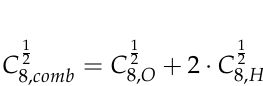
Figure 5. Position r M of the off-atom (M) site along the x -axis in Figure 1 versus the root-mean-square Figure 5: Position r of the off-atom (M) site along the x-axis in Figure 1 versus the root- M deviation (RMSD) between the partial-charge fitted and QM (B3LYP/QZ4P) estimated molecular mean-square deviation (RMSD) between the partial-charge fitted and QM (B3LYP/QZ4P) electrostatic potential in the gas estimated molecular electrostatic potential in the gas phase.